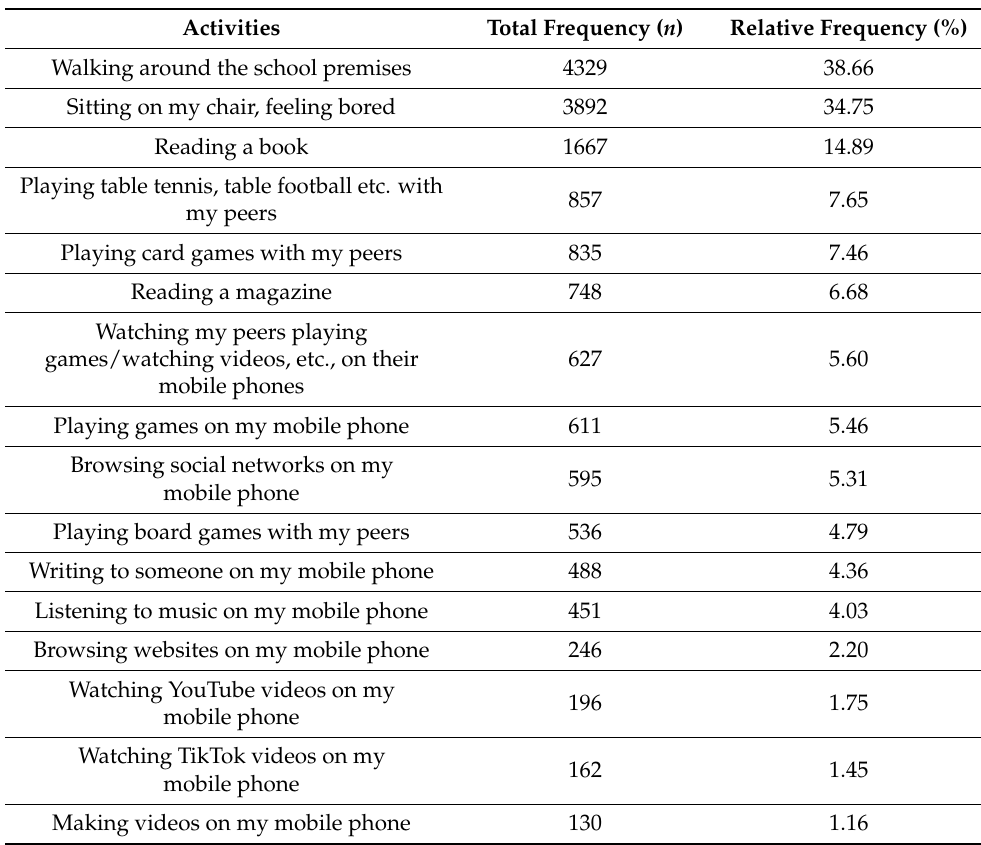
Table 4. The most frequent break time activities—schools where mobile phones are not allowed during break time.